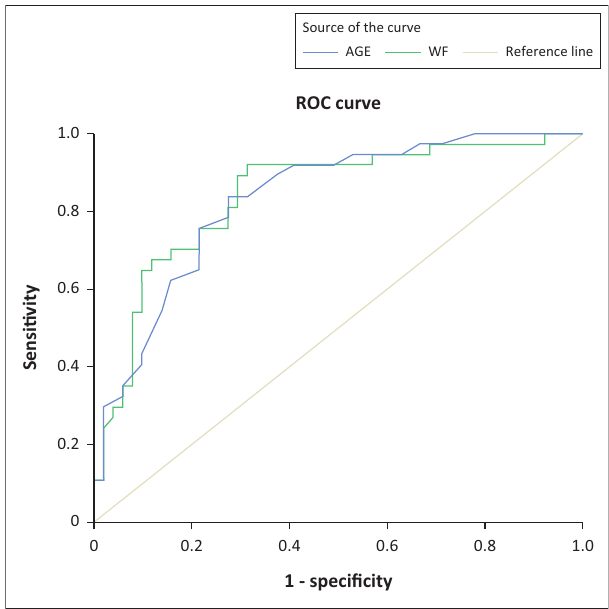
FIG URE 1: Results of the receiver operating characteristic analysis. TABLE 3: The presence of steatosis in subgroups of patients (formed according to the cut-off values of the visceral fat and age). Subgroups of